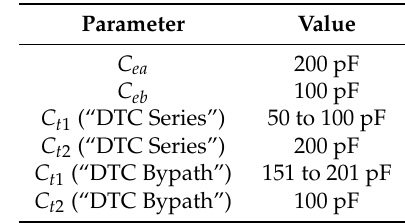
Table 4. Parameters of the circuit components for the alternating current (AC) sweep.